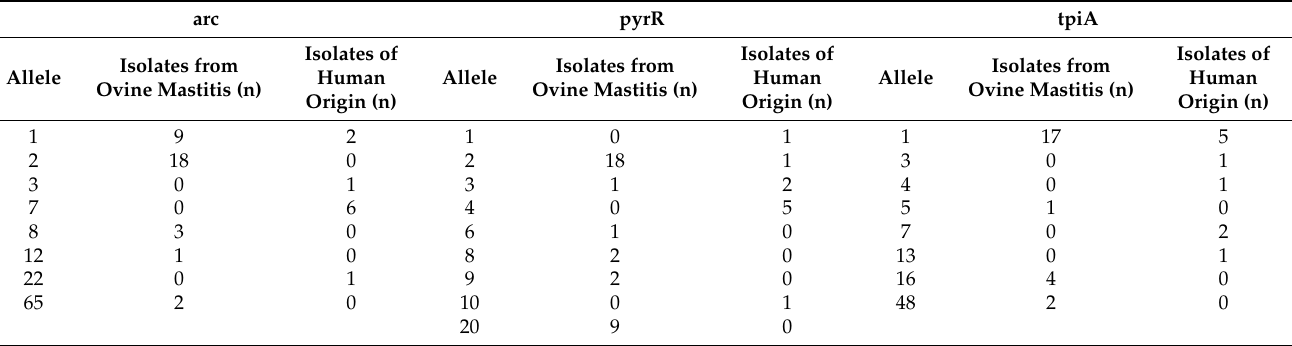
Table 4. Frequency of alleles of the genes arcC , pyrR and tpiA in S. epidermidis isolates from cases of ovine mastitis ( n = 33) or human patients ( n = 10) in the MLST database, recovered in Greece.